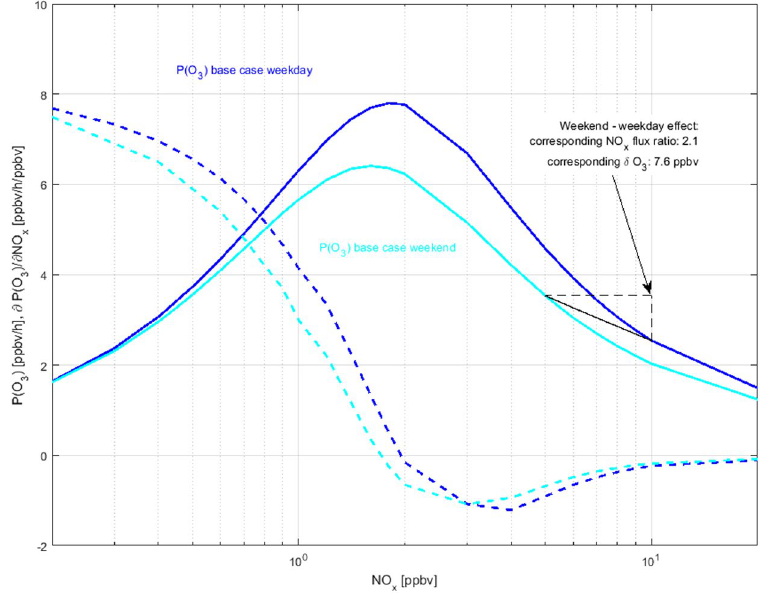
Figure 3. Calculated ozone production rates (solid lines) and derivatives (dashed lines) as a function of NO x . Blue and cyan represent base cases for the study site, taking into account changes in O 3 , NO x and NMVOCs concentrations. The solid black line follows the observed weekend-weekday